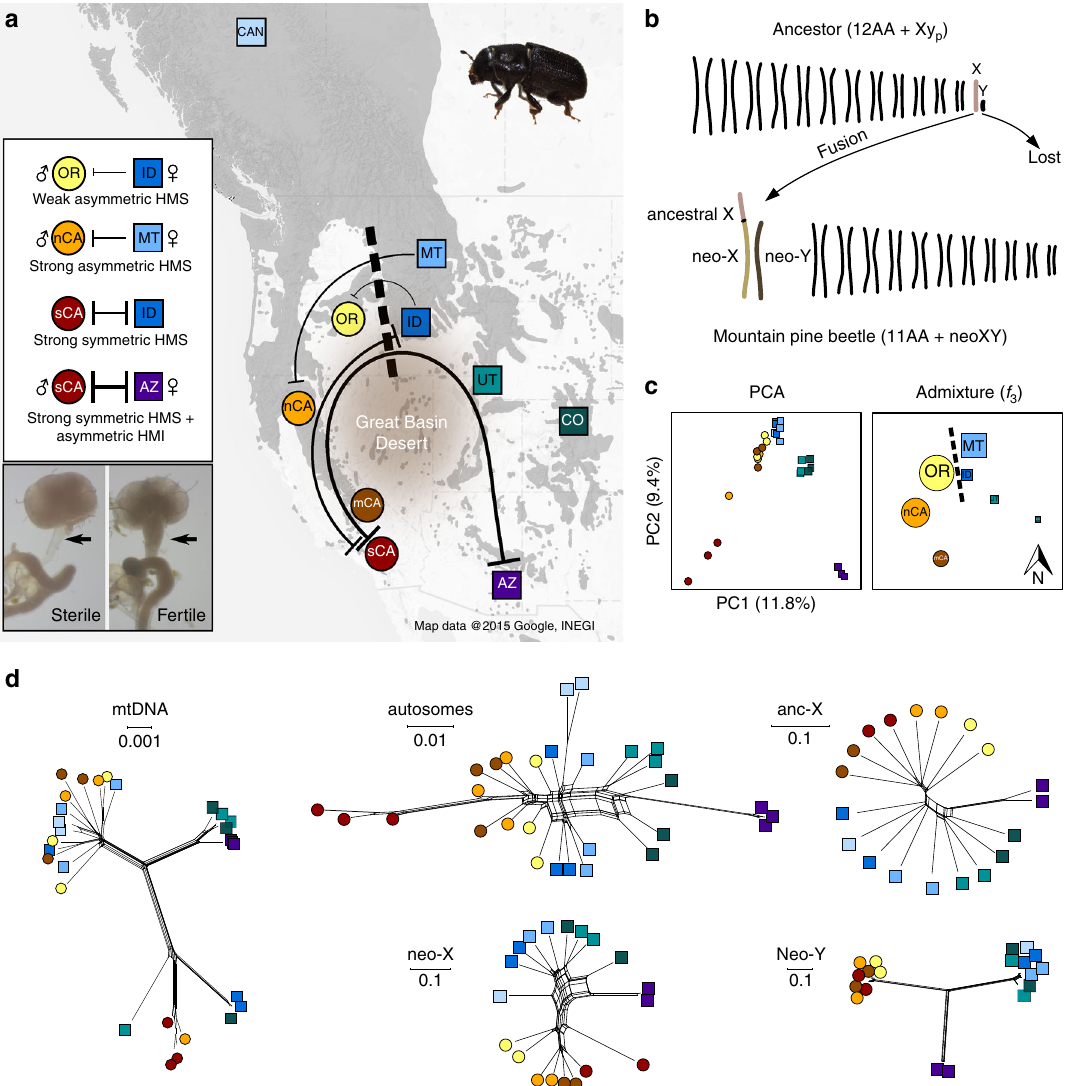
Fig. 2 Reproductive isolation and genomic differentiation. a The mountain pine beetle occurs in close association with host trees in western North America (dark grey) and gene fl ow is thought to be restricted across the Great Basin Desert. We combined extensive genetic crossing data with beetle genomes sequenced from ten localities (circles and squares; all relevant crossing shown in Supplementary Fig. 1). Reproductive isolation was observed between localities connected with lines, increasing in severity (top left inset) with distance from a central boundary (dashed line; See also Supplementary Fig. 2 and Supplementary Table 1). Sex symbols denote the direction of the cross when any asymmetric isolation (HMS or HMI) was observed (top left inset). Sterile males show reduced quantities of sperm in the seminal vesicle (bottom left inset; see also Supplementary Fig. 3). b Model of neo-sex chromosome evolution in the mountain pine beetle (and D. jeffreyi ) from an ancestral X-autosome fusion. The ancestral Xy p notation describes systems where the Y chromosome is small and highly degenerate and the X forms a ‘ parachute ’ like structure while pairing at a distance from the Y during meiosis 12 . c Results from principal component (left) and admixture analyses ( f 3 statistics, right) for autosomal SNPs across all population comparisons. Signi fi cantly admixed populations are positioned by geography and symbol size scaled relative to the number of signi fi cant three-population tests (Supplementary Table 3) supporting admixture of the focal population ( z -score < − 10). d SplitsTree networks for mtDNA and four nuclear genomic partitions (autosomes = 60 K SNPs, anc-X = 87 K, neo-X = 75 K, neo-Y = 544). For additional analyses of population structure see Supplementary Fig. 7 and Supplementary Table